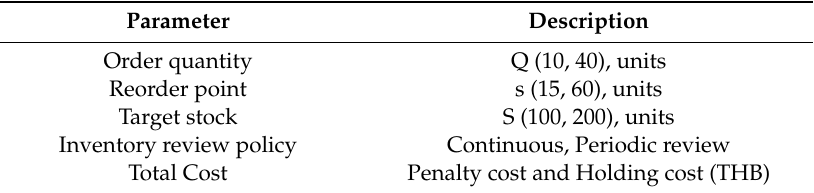
Table 4. Low and high values for